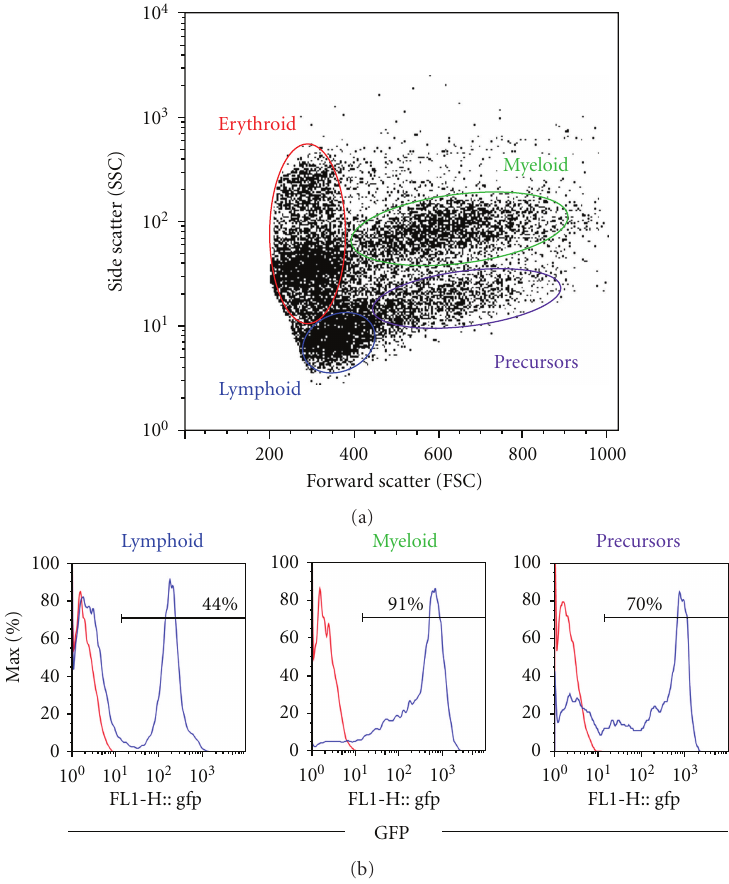
Figure 1: Flow cytometry analysis of zebrafish whole kidney marrow from a marrow transplant recipient. Zebrafish transplant recipients were irradiated and injected with 5 × 10 5 marrow cells from a transgenic β -actin:GFP donor. Whole kidney marrow from a representative recipient was dissected 3 months later and analyzed by flow cytometry. (a) The forward scatter (FSC) versus side scatter (SSC) profile of zebrafish whole kidney marrow shows four cell populations: erythroid, lymphoid, myeloid, and precursor cells. (b) Histograms for GFP expression of cells within the lymphoid, myeloid and precursor gates show multilineage engraftment with GFP + donor cells (blue lines). The red lines show GFP expression in a wild-type-negative control